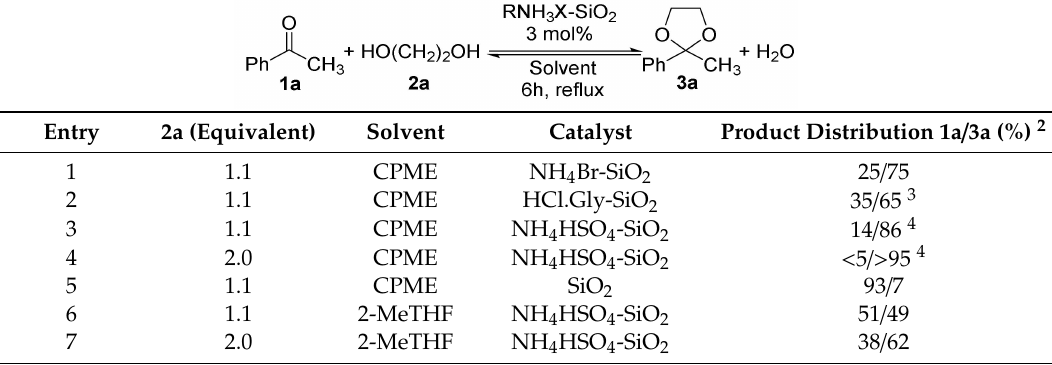
Table 3. Synthesis of dioxolane 3a in the presence of SiO 2 -supported ammonium salts